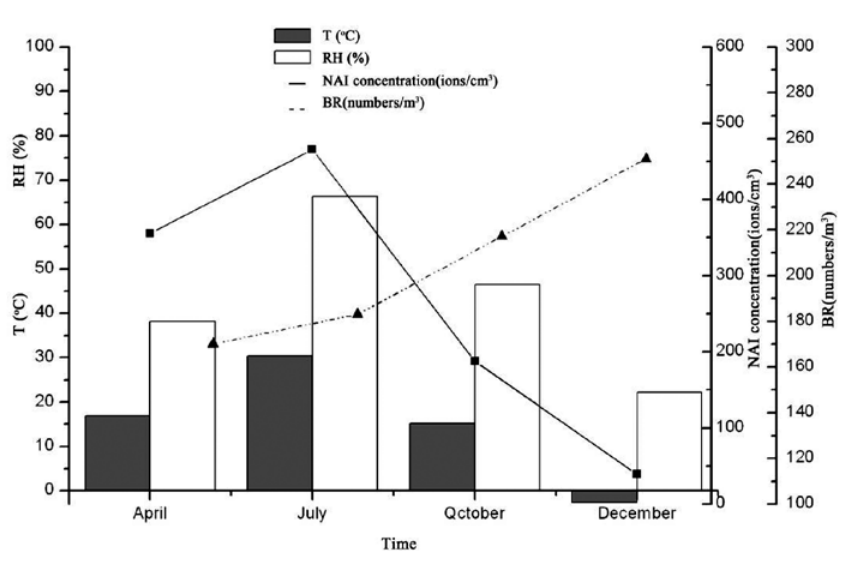
Fig. 16. Correlation between T, RH and the NAI concentration, BR at